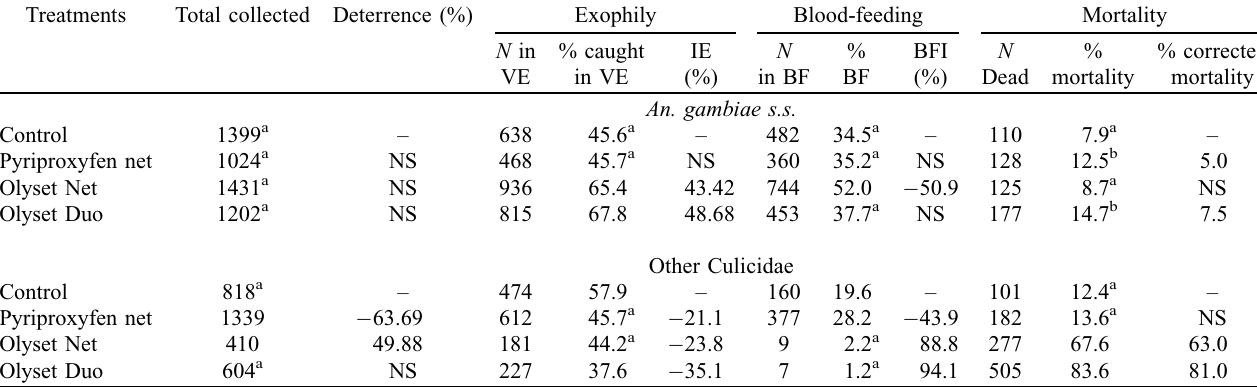
Table 2. Summary results of the experimental hut trial against wild free-flying Anopheles gambiae s.l. resistant to insecticides and other Culicidae